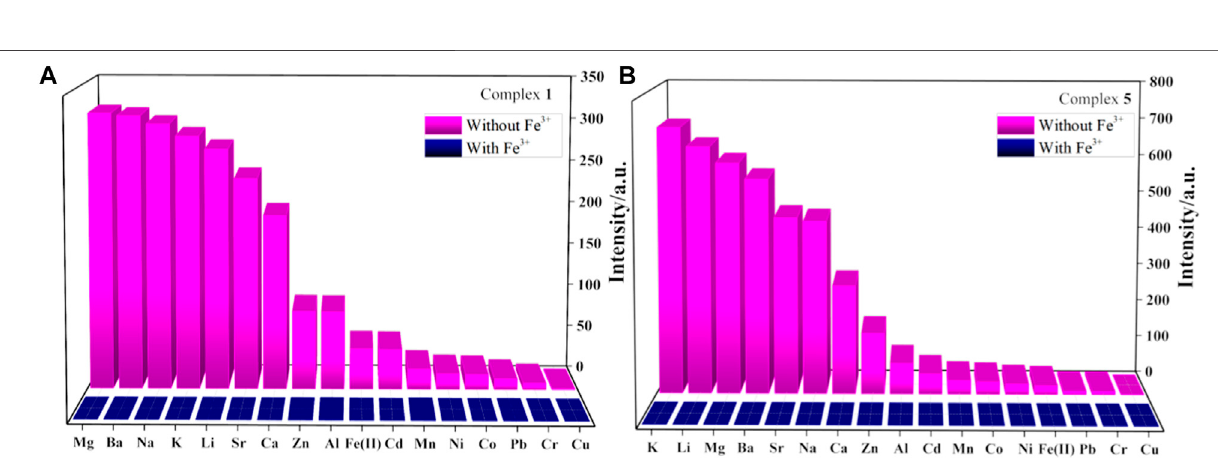
Frontiers in Chemistry |